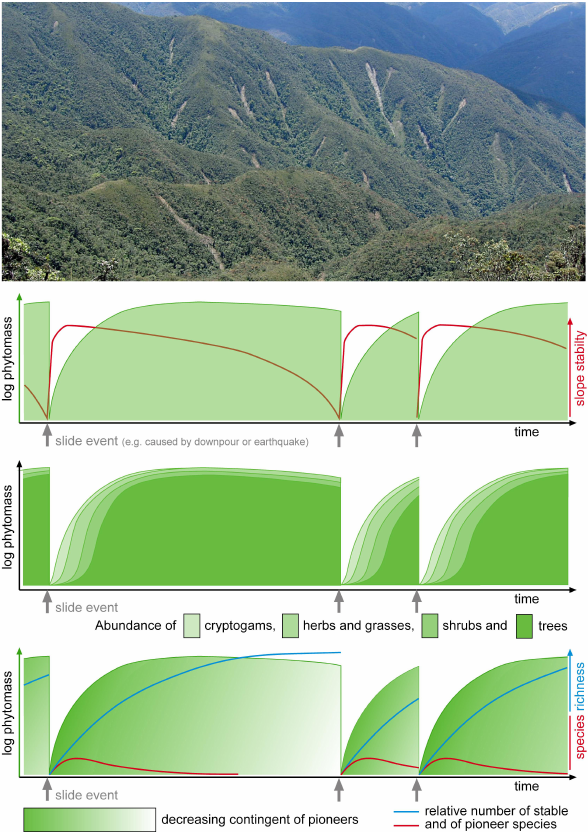
Fig. 5. Landsliding as trigger for regenerative mosaic cycles of mountain rainforests. Active sliding zone between 2300 and 2600ma.s.l. on the terrain of the Reserva Biol´ogica San Francisco in southern Ecuador (a) ; (b) depicts the relationship between phy- tomass (green field) and slope stability (red line); biomass weight causes overloading and leads to slope instability. Arrows indicate the occurrence of landslide events; (c) illustrates non-linear trajec- tories describing changes in the abundance of different functional groups of plants through time (area under each curve); (d) high- lights the additional input of vascular plant pioneers recolonising the landslides. The time scale is on the order of few